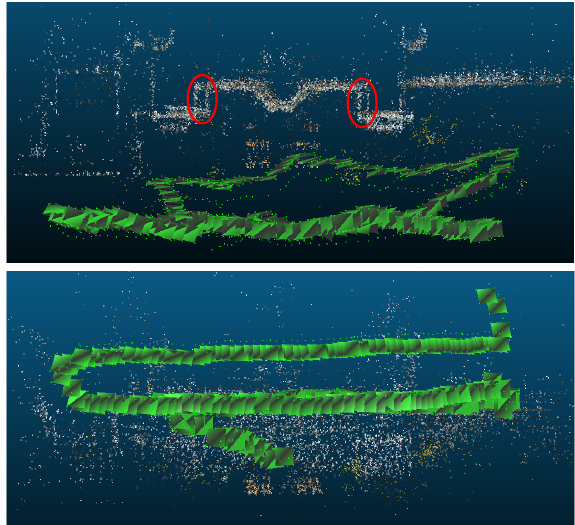
Figure 2: Point cloud and oriented images of an image sequence consisting of 233 images seen from above (first row) and from the front (second row). Regions that are highly affected by an offset are highlighted in red. Figure 3: Mean standard deviations of the position X 0 (a) and the rotation parameters [ ω, φ, κ ] of the projection centre (b) and the object points (c) in [ baselengths ] and [ gon ] after each incre- mental bundle adjustment iteration for our approach (green/solid) and the algebraic approach